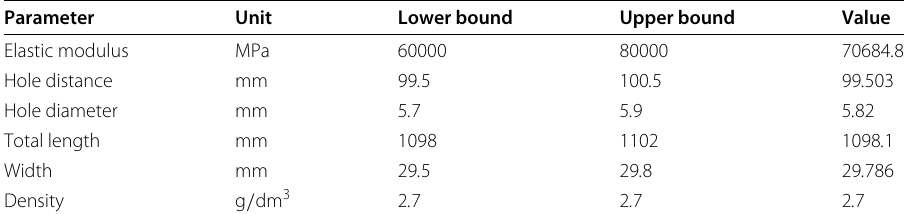
Table 5 Boundaries and fitted values for the beam with hole sample